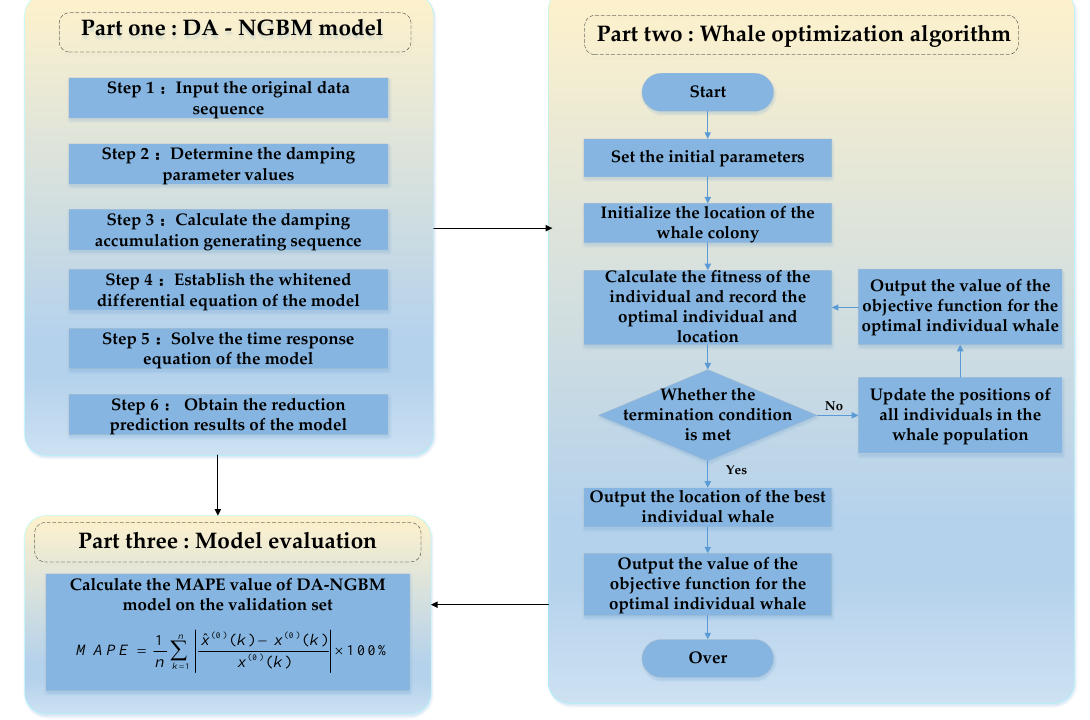
Figure 1. Modeling flow chart of DA – NGBM model.